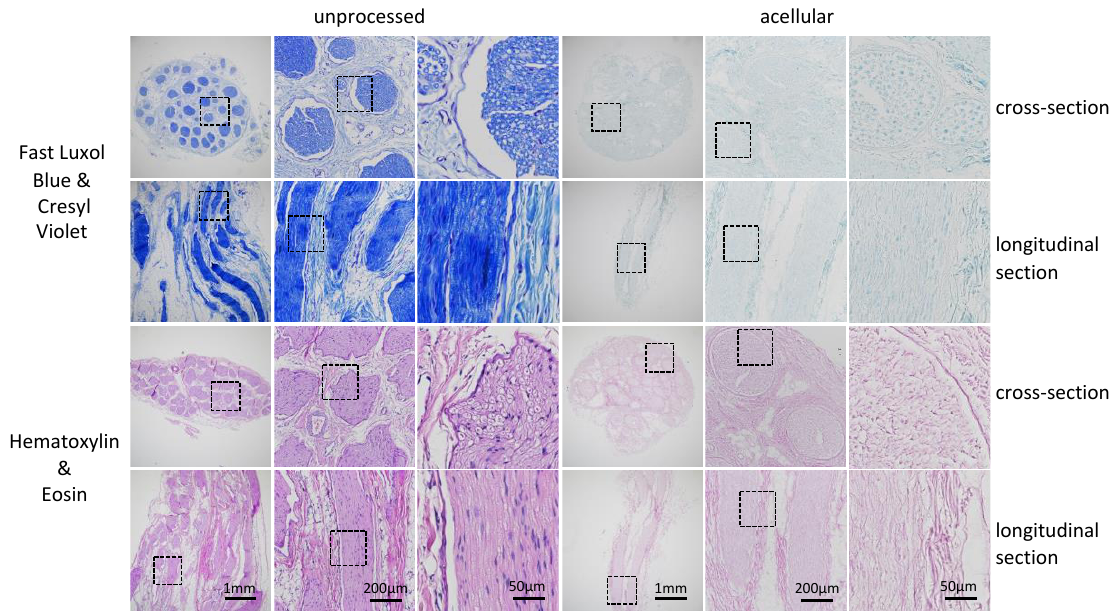
Figure 4. Histological analysis of the ECM and the remaining myelin structure of protocol 5. Luxol fast blue and Cresyl violet stain: myelin (blue) and nuclei (purple) (top). Hematoxylin and eosin stain: ECM (pink) and nuclei (purple) ( bottom ). The 5 µ m thick cross-sections and longitudinal sections zoomed into framed segments. Sca le: 1 mm, 200 μm, 50 μm.